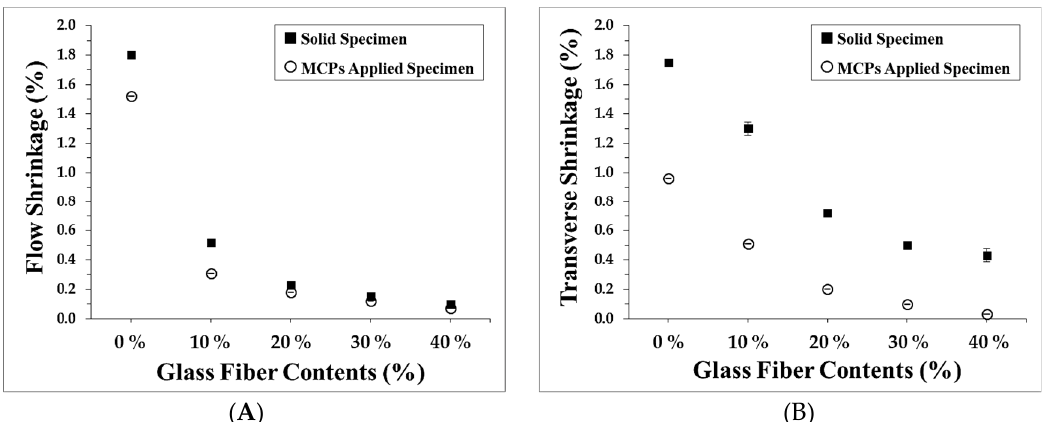
Figure 4. Shrinkage of specimens: ( A ) Flow shrinkage and ( B ) Transverse shrinkage.